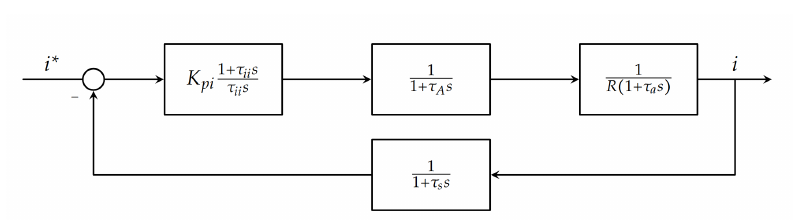
Figure 4. Current controller for AMB with feedback